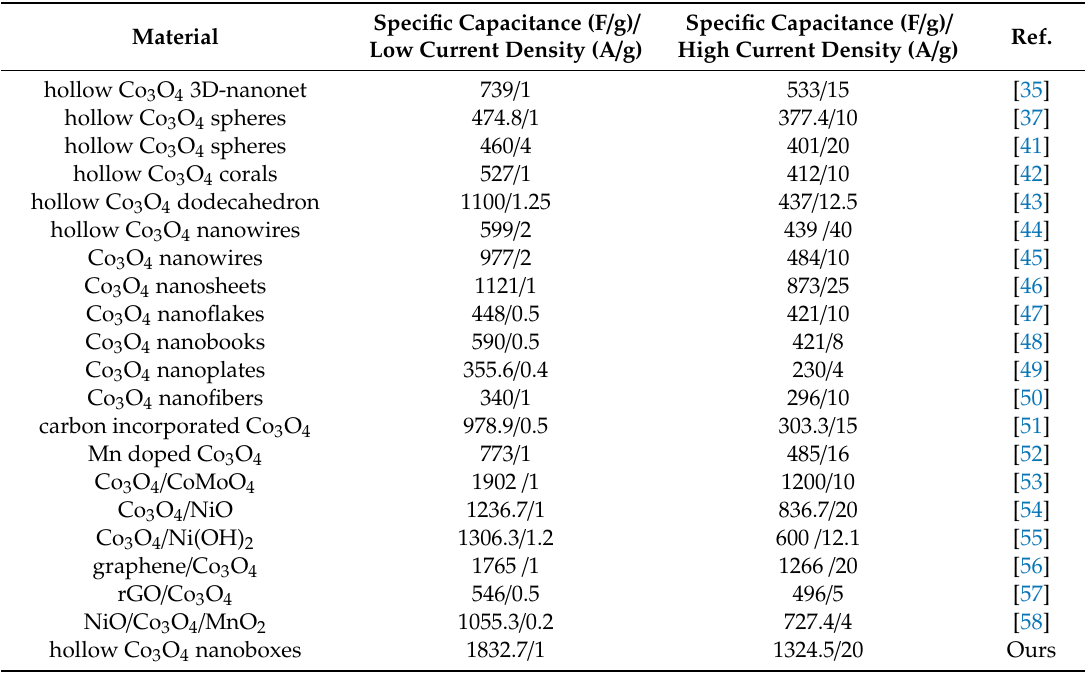
Table 1. Specific capacitances at low current density and high current density (rate performance) of Co 3 O 4 based electrode